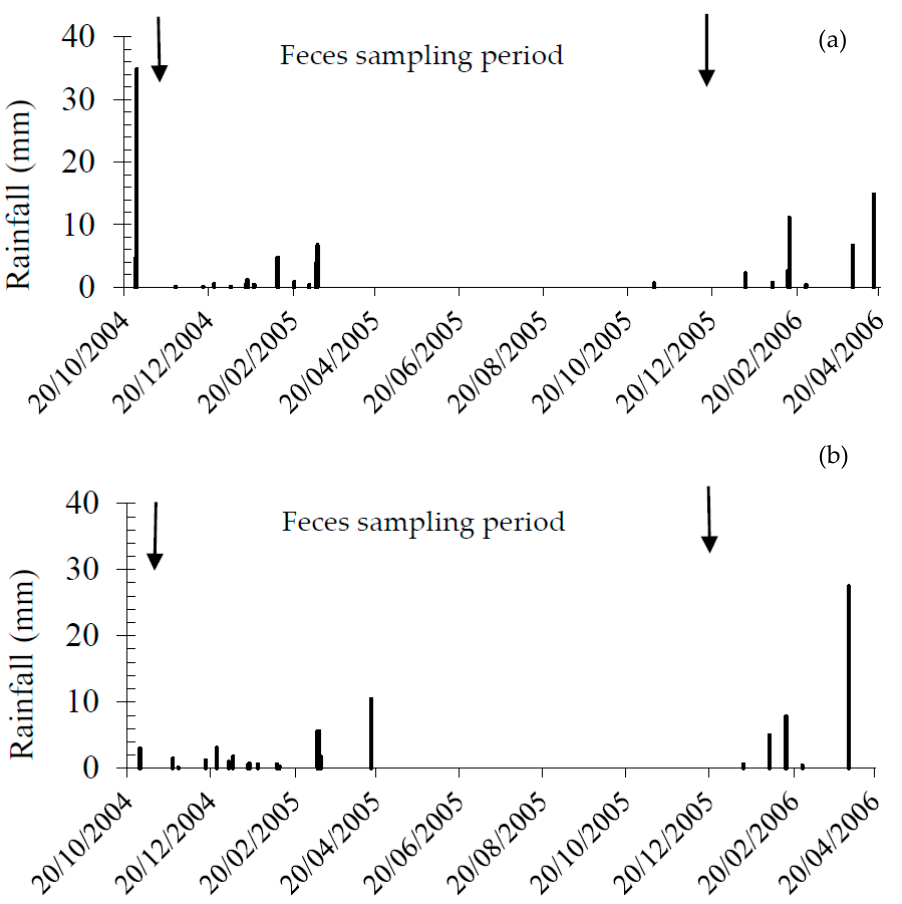
Figure 2. Rainfall during the project in the Arava ( a ) and Paran ( b ) sites: arrows indicate the initiation and end of fecal sampling period.